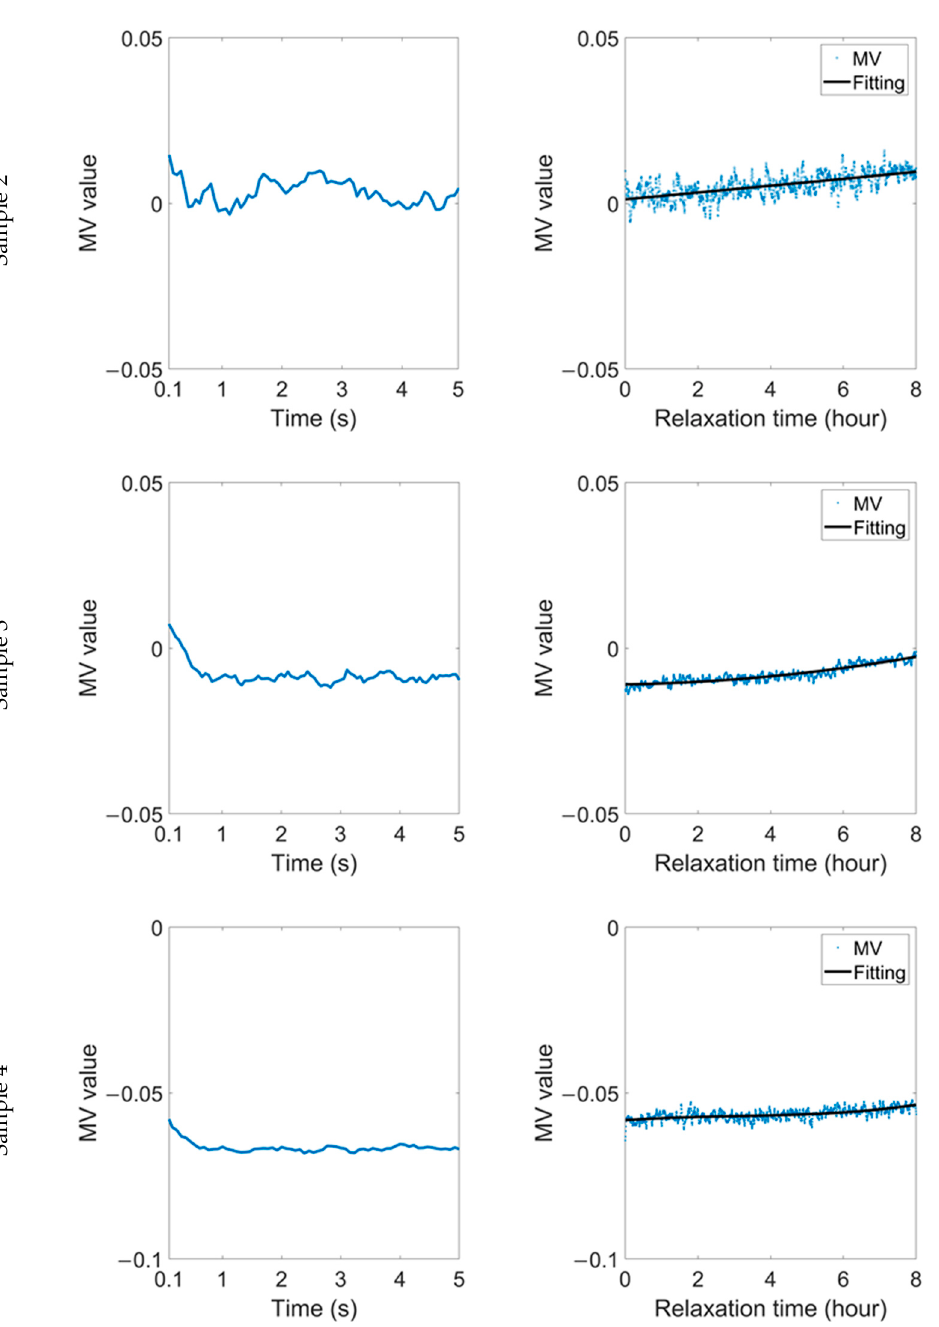
Figure 8. Variation in MV parameter during relaxation time after 1.5% strain was removed after the samples had been in plastic status for 45 days.